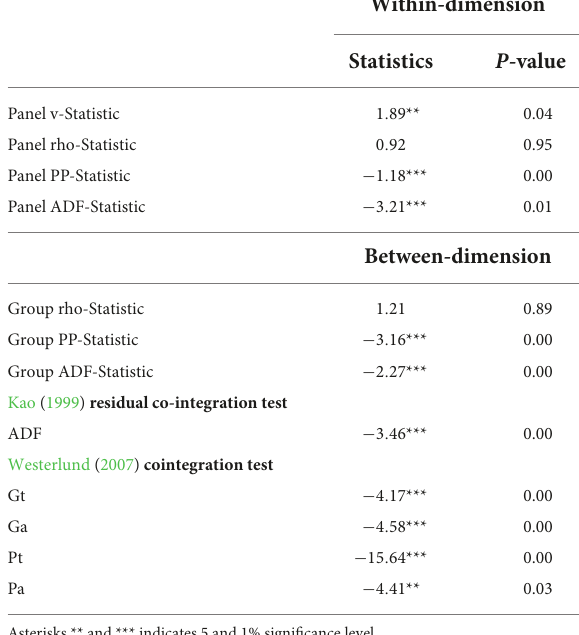
TABLE 4 The findings of panel cointegration test by Pedroni (1999, 2004), Kao (1999) residual cointegration test, and Westerlund (2007) cointegration test.